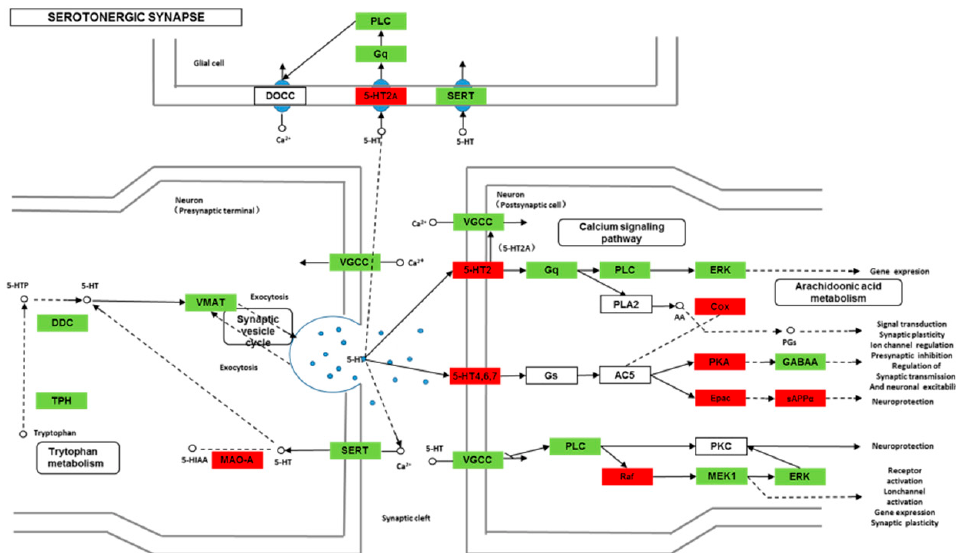
Figure 8. Differentially expressed genes in the serotonergic synapse between mandarin fish in the control group (CG) and the learning group (LG) from a transcriptome analysis. The colors of rectangles were shaded according to the different expression (red: The mRNA expression levels of fish in Group LG were significantly higher than those in Group CG (FDR ≤ 0.001, the absolute value of log2 (Ratio) ≥ 1); green: The mRNA expression levels of fish in Group LG were significantly lower than those in Group CG (FDR ≤ 0.001, the absolute value of log2 (Ratio) ≥ 1)).